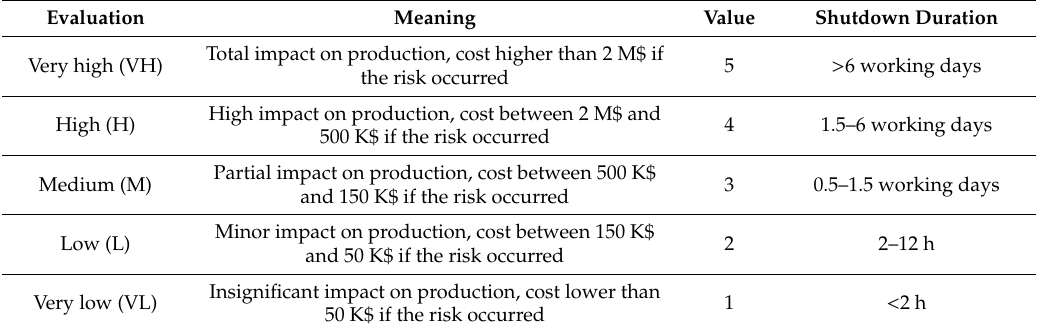
Table 4. Evaluation scale for the factor of